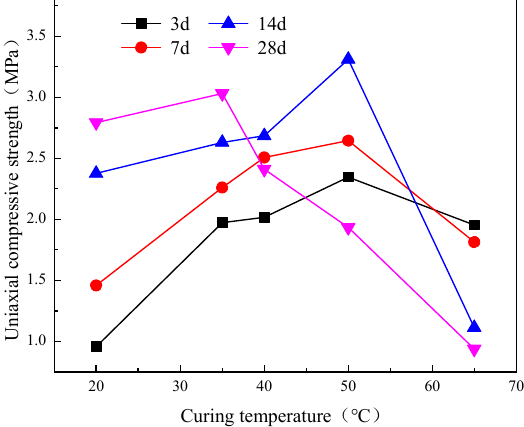
Figure 6. Change in strength with curing temperature at 3d, 7d and 14d.